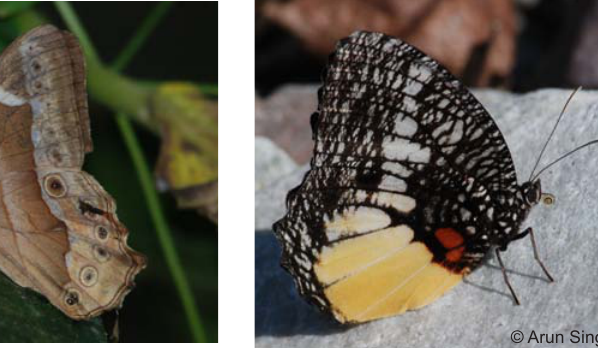
Image 36. Common Red Forester Lethe mekara